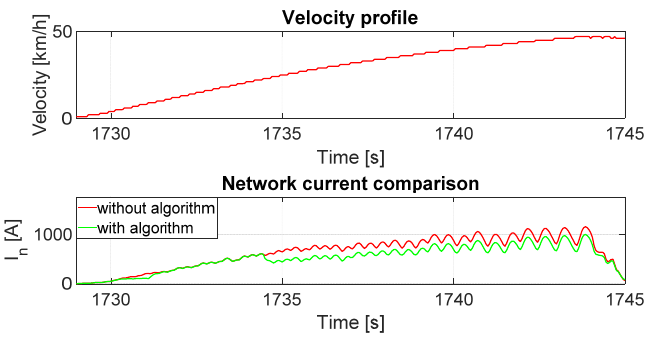
Figure 15. Enlarged view of the speed profile and grid current.